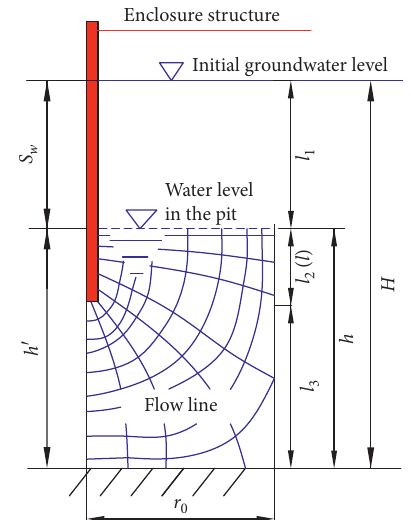
Figure 3: Seepage field distribution in the pit.